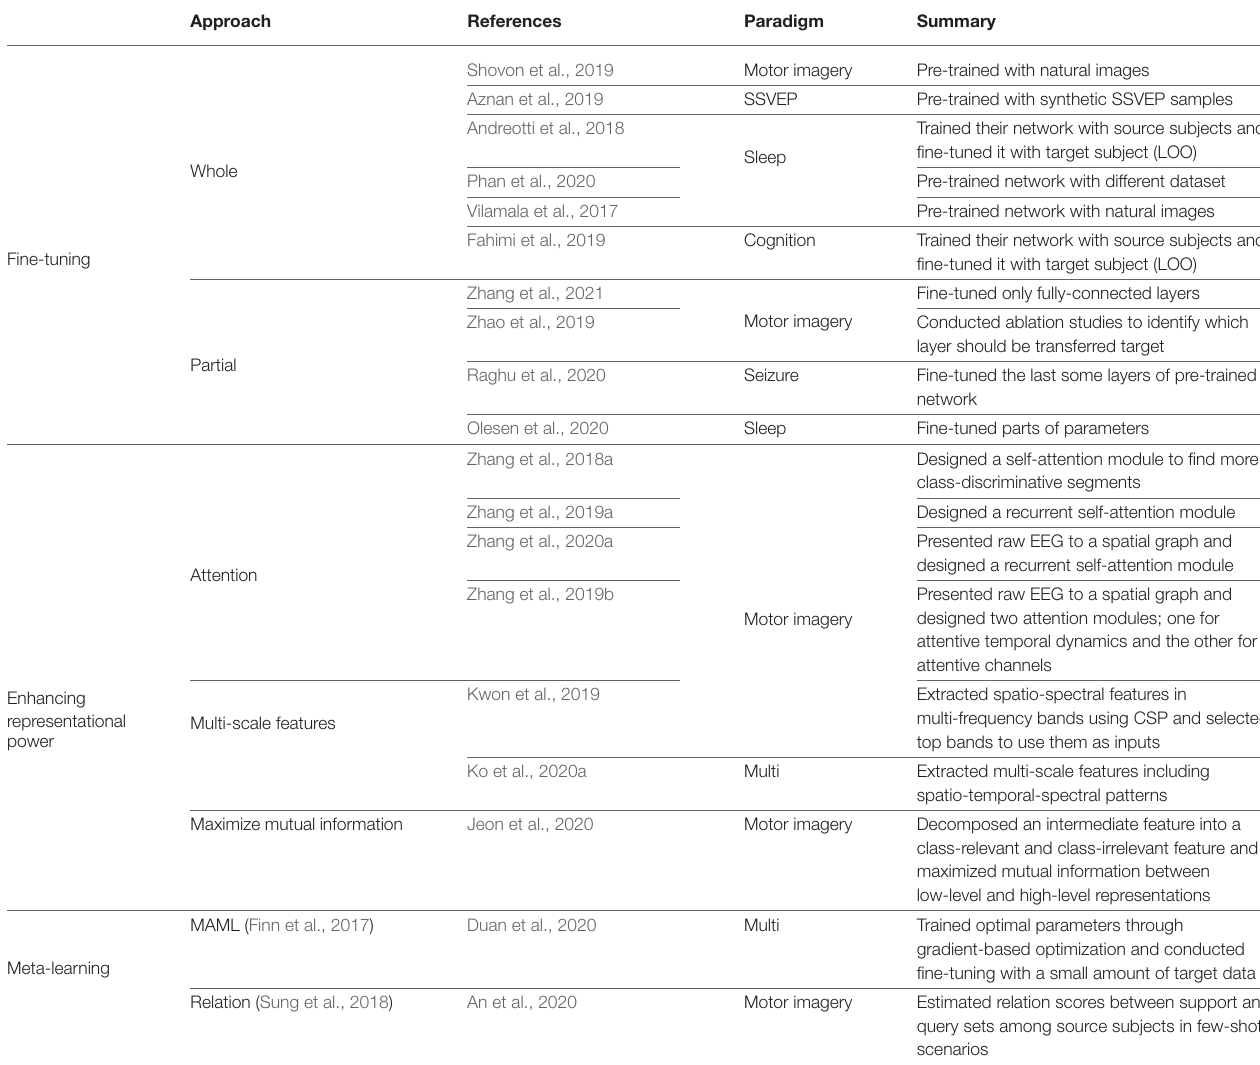
TABLE 4 | Implicit transfer learning